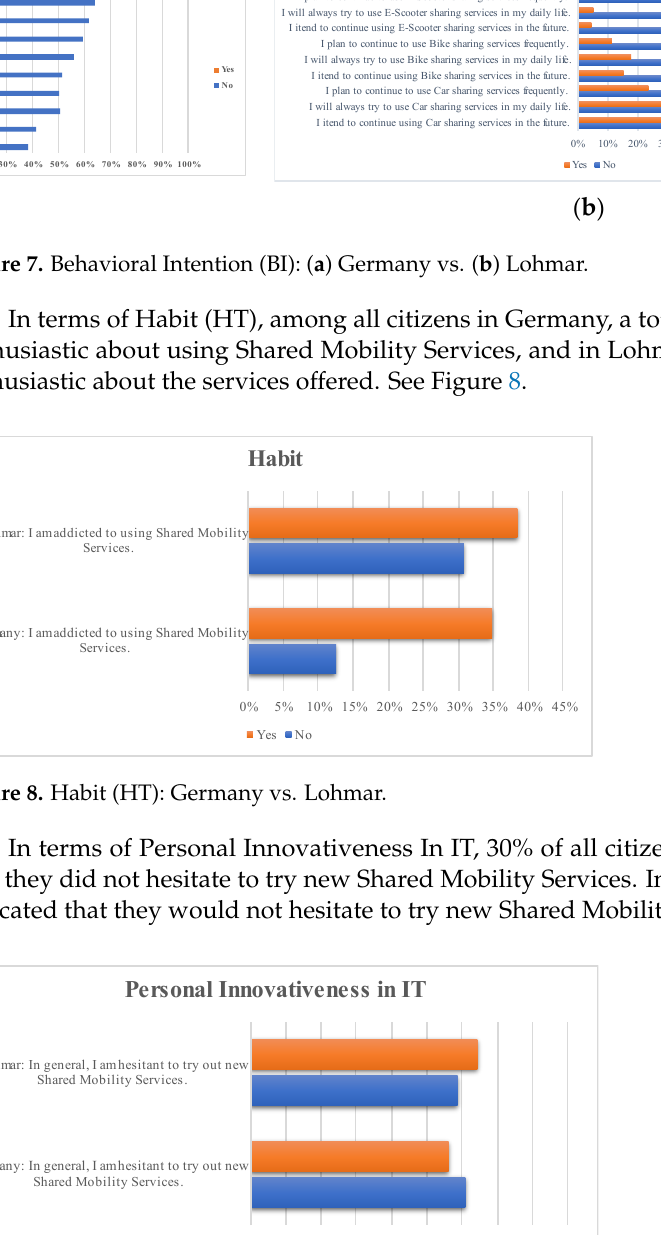
( b ) Figure 5. Performance Expectancy (PE): ( a ) Germany vs. ( b ) Lohmar. In terms of Effort Expectancy (EE), 72% of all citizens find Shared Mobility Services easy to learn and use, and 63% of citizens from Lohmar agreed with this statement. For 57% of all citizens, the use of Shared Mobility Services is clear and understandable, and in Lohmar, 44% also stated that handling of Shared Mobility Services is easy for them. Shared Mobility Services were reported to be easy to use by 54% of all Germans and 36% of Lohmar residents. In addition, 53% of all citizens stated that Shared Mobility Services are easy to handle and 40% in Lohmar agreed with this statement. See Figure 6. ( a )